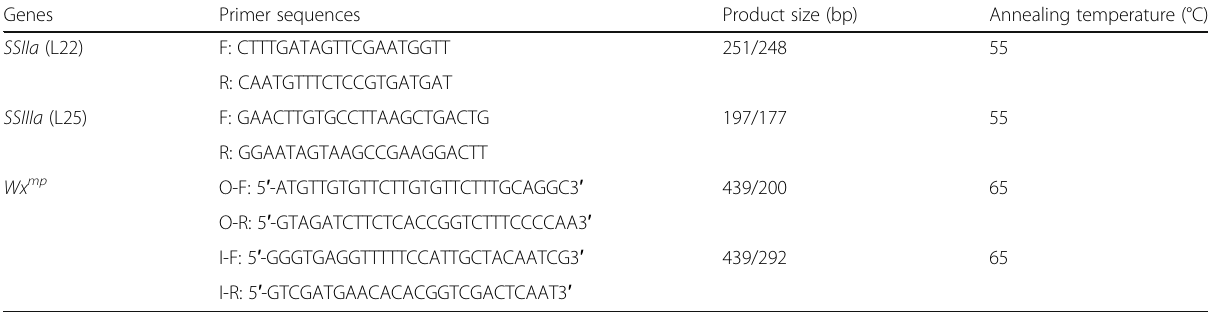
Table 1 Molecular markers of SSIIa , SSIIIa and Wx mp genes used in this study Genes